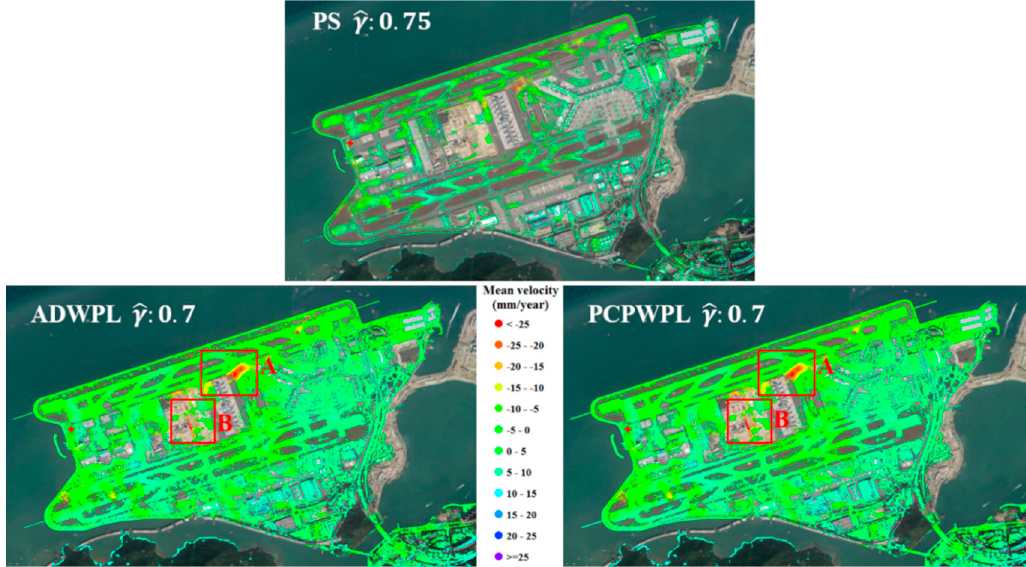
Figure 17. Geocoded deformation velocity of PS result, ADWPL result, and PCPWPL result. DSs are detected under ˆ γ = 0.7. Values are displayed in the normal vertical direction, assuming all the LOS deformation are due to vertical movement. Reference point is marked as red cross, background optical map is from Google Earth.